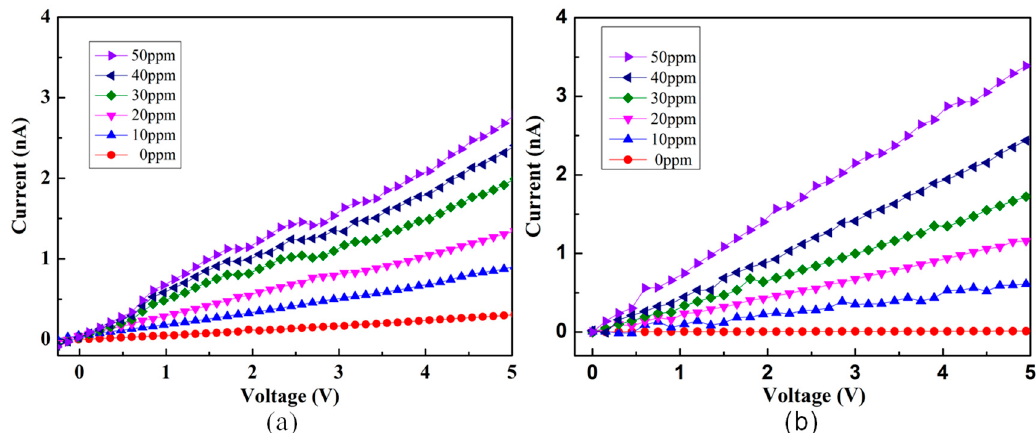
Figure 4. I-V curves of the two groups of fiber membranes measured under different ammonia concentrations. ( a ) Conventional fibers electrospun under 20 kV (average fiber diameter of 263 nm), ( b ) ultrafine fibers electrospun under 70 kV (average fiber diameter of 68 nm). The ammonia concentration increased from 0 ppm to 50 ppm.